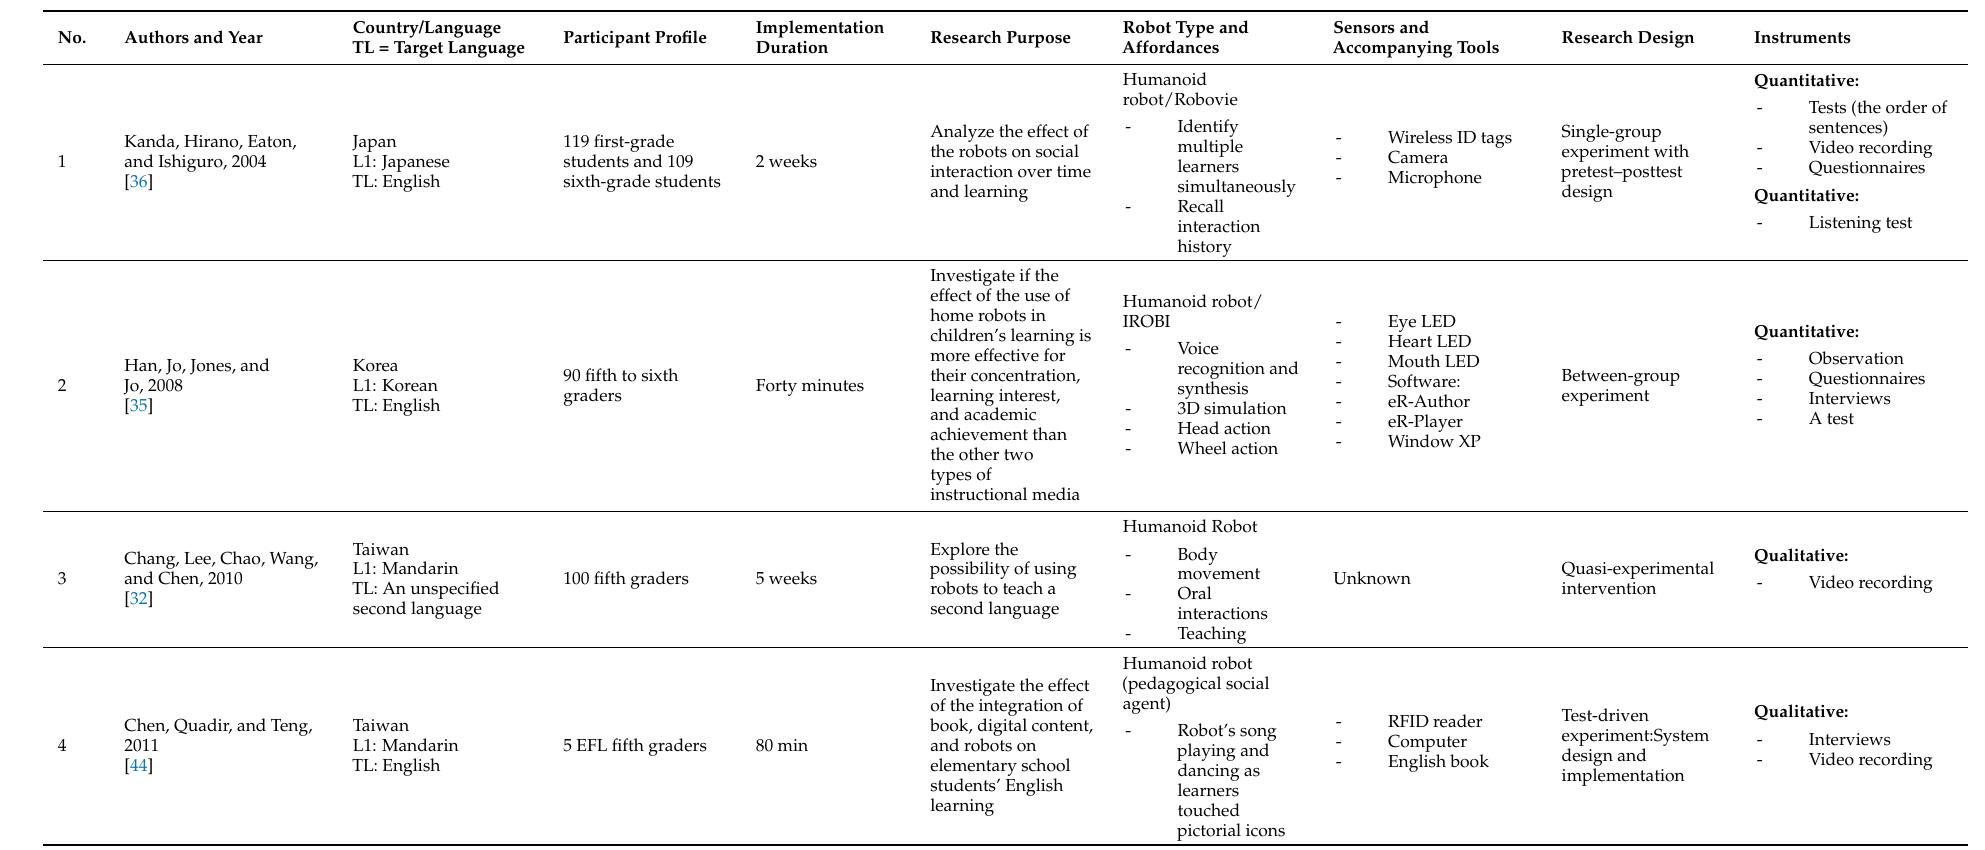
Table A1. General Profile of the Reviewed Studies on